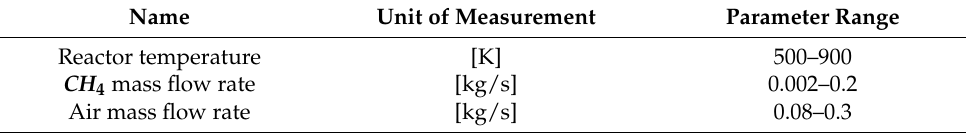
Table 3. Range adopted for the three parameters considered for the plant model